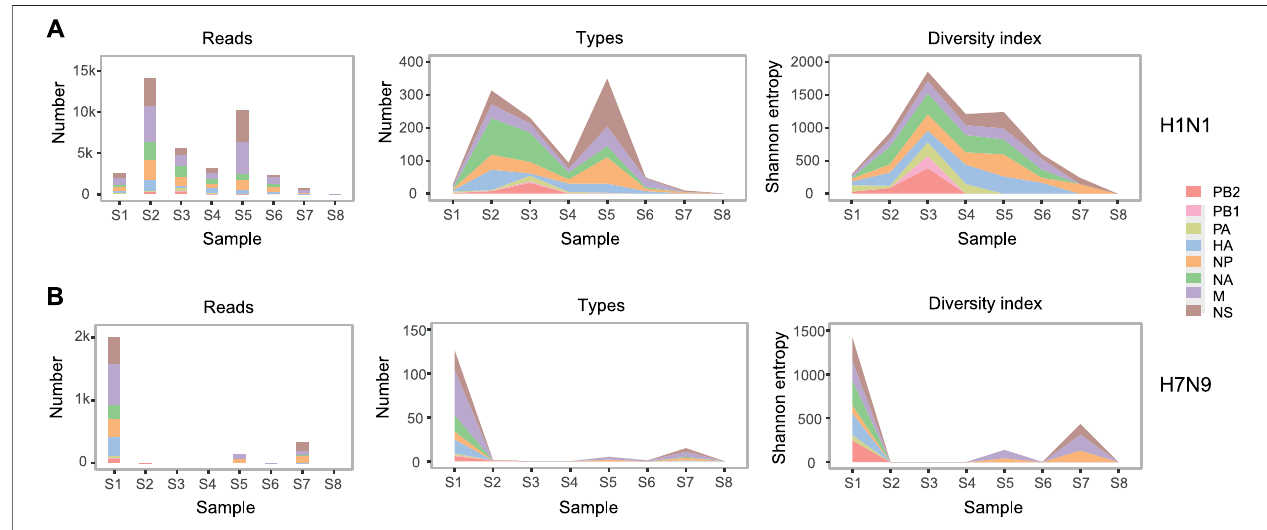
FIGURE 2 | The abundance and diversity of H1N1 and H7N9 genomic sequences. In H1N1 (A) and H7N9 (B) , from left to right, three subgraphs respectively indicate the number of sequence reads, the number of sequence types and the sequence diversity index in each group. In each subgraph, eight colors represent eight genomicsegmentsofin fl uenzaAvirus.Onesequencetypeisde fi nedthatthereareoneormoredifferentbasesfromanyothersequence.Thesequencediversityindexis calculated as the Shannon entropy formula described in the “ Materials and Methods ” . The detailed values about abundance and diversity of genomic sequences are listed in Supplementary Table S3.